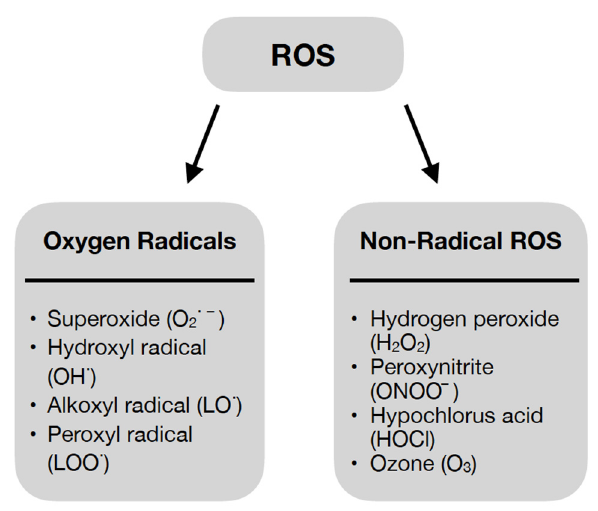
Figure 2. Oxygen Radicals and Non-Radical Reactive Oxygen Species [27].